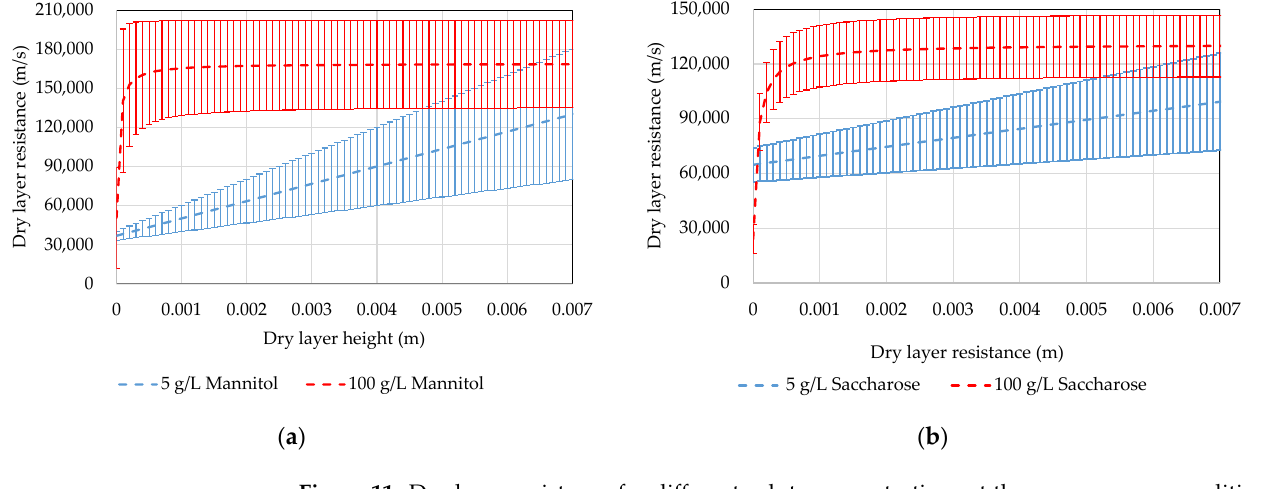
Figure 11. Dry layer resistance for different solute concentrations at the same process conditions: ( a ) Mannitol ( b ) Saccharose.